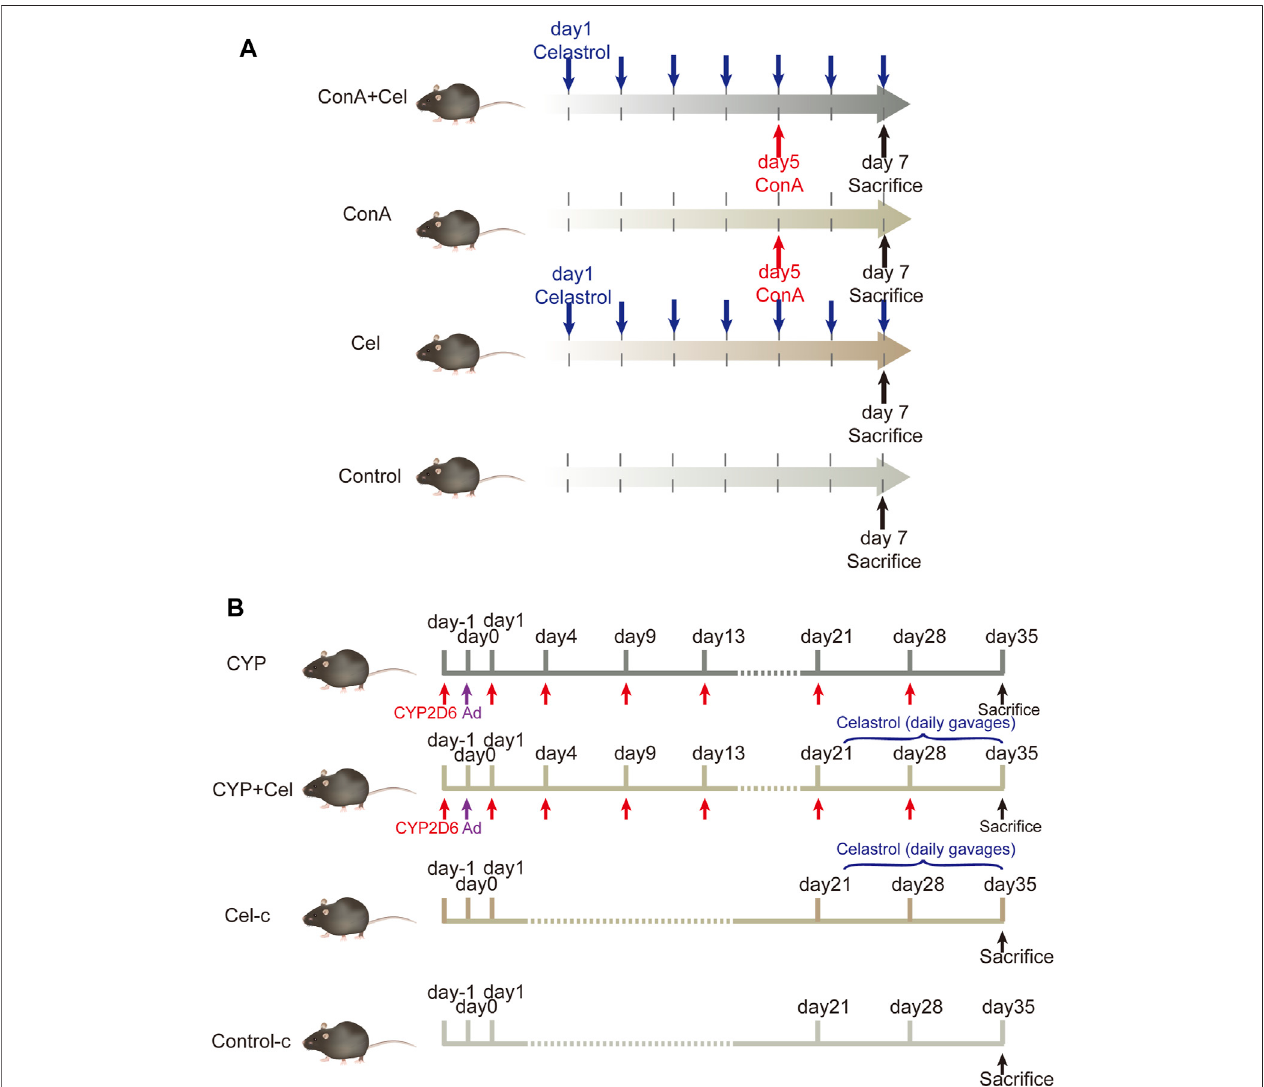
FIGURE1 | Animal models and experimental design. (A) The intervention cycle in ConA-induced acute liver injury models. (B) The intervention cycle in chronic AIH models.